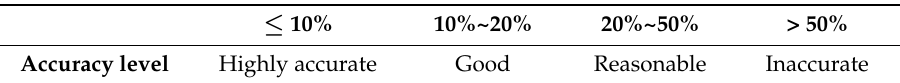
Table 5. MAPE accuracy